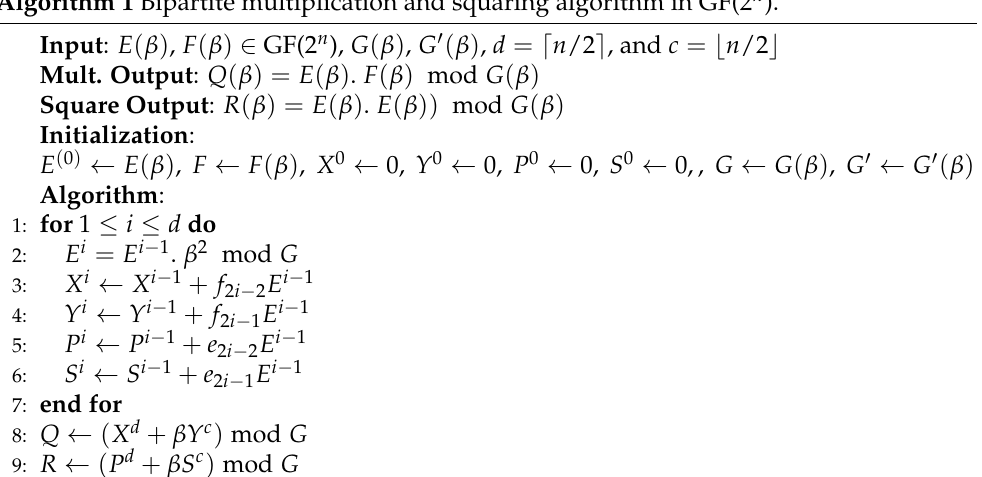
Algorithm 1 Bipartite multiplication and squaring algorithm in GF(2 n